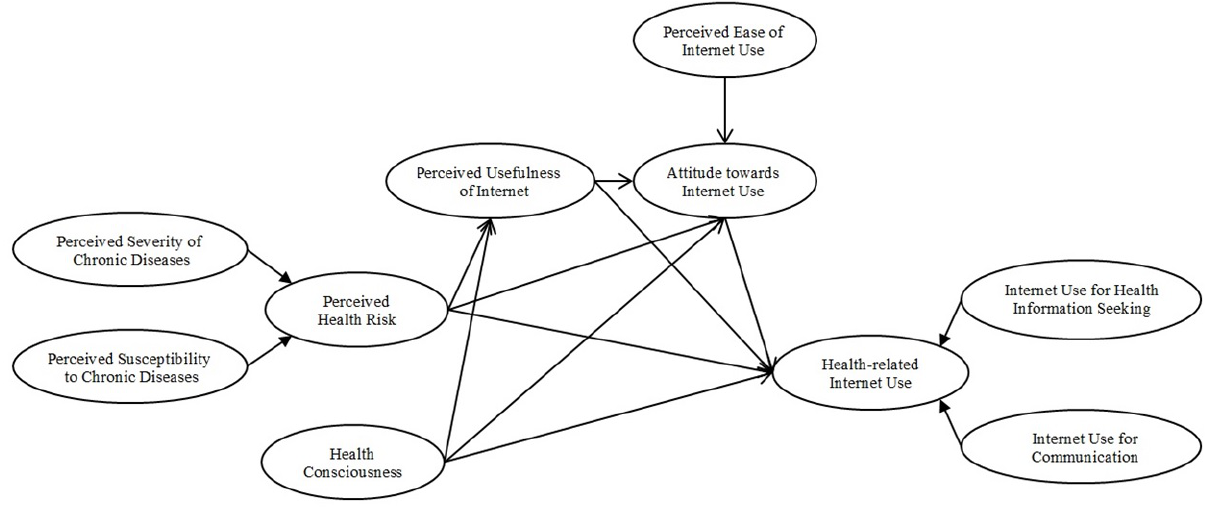
Figure 3. Integrated model based on the Health Belief Model and the Technology Acceptance